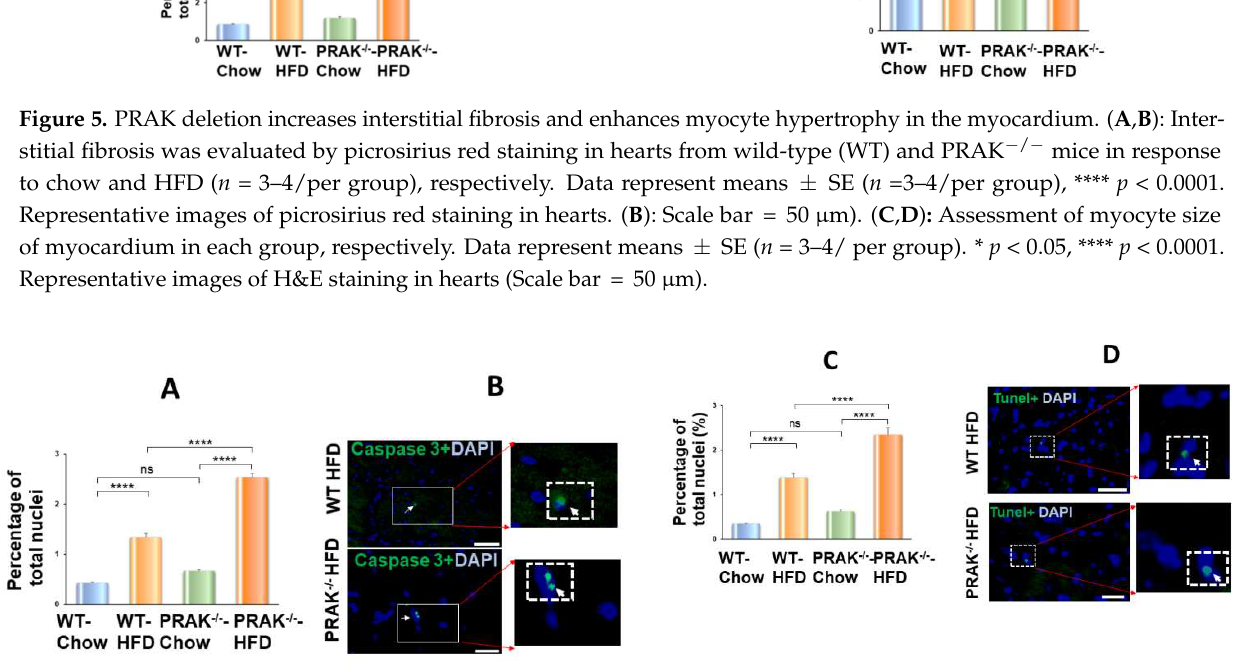
Figure 6. PRAK deletion increases apoptotic frequency in the myocardium. ( A , B ) Extent of apoptosis in hearts were evaluated by staining with cleaved caspase 3 ( n = 3–4/per group).Data represent means ± SE. **** p < 0.0001. ( C , D ) Extent of apoptosis in hearts were evaluated by terminal deoxynucleotidyl transferase nick-end labeling (TUNEL) assay ( n = 3–4/per group). **** p < 0.0001.